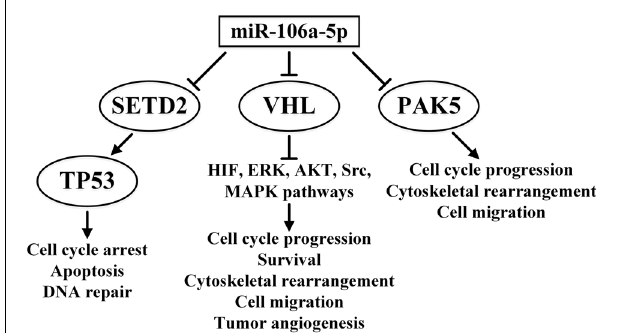
FIGURE 2 | Multiple features of the effects of miR-106a-5p in ccRCC signaling pathways. The overwhelming effect of miR-106a-5p on tumor suppressors TP53 and VHL and oncogene PAK5 is presented. ↑ indicates activity stimulation and (cid:62) indicates activity suppression according to any of the